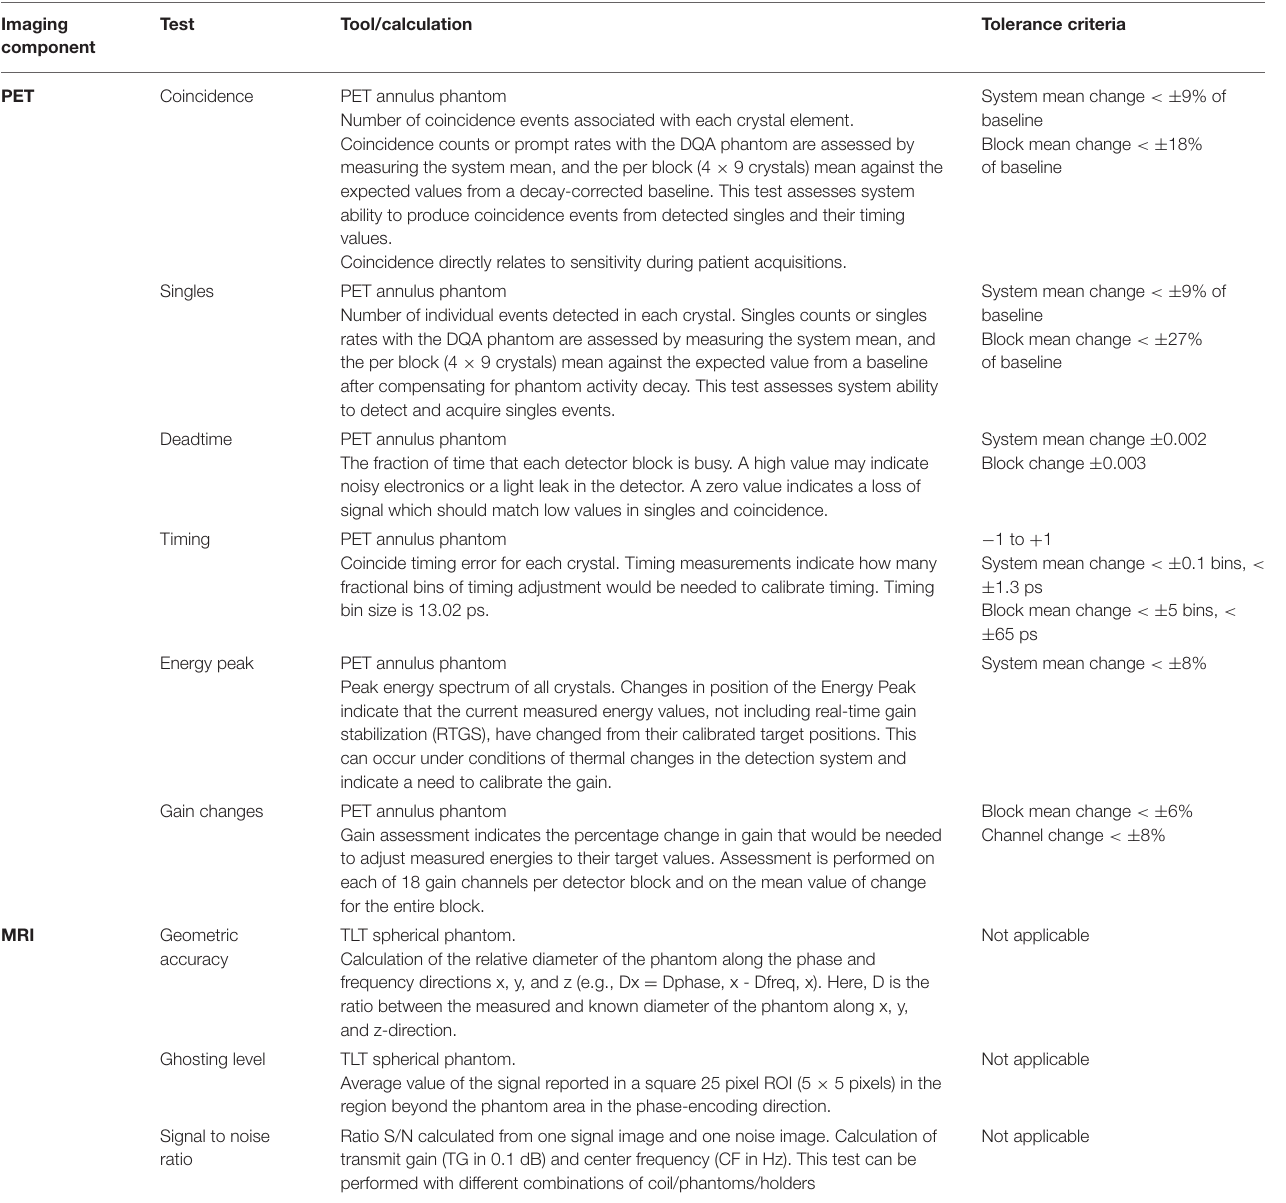
TABLE 5 | DQA tests for GE SIGNA PET/MR systems. Imaging